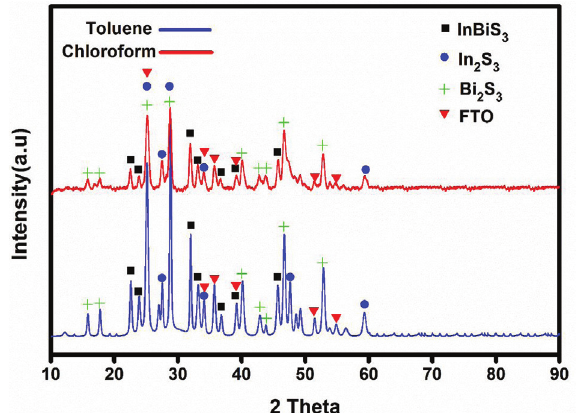
-In S -Bi S composite thin films 3 2 3 2 3